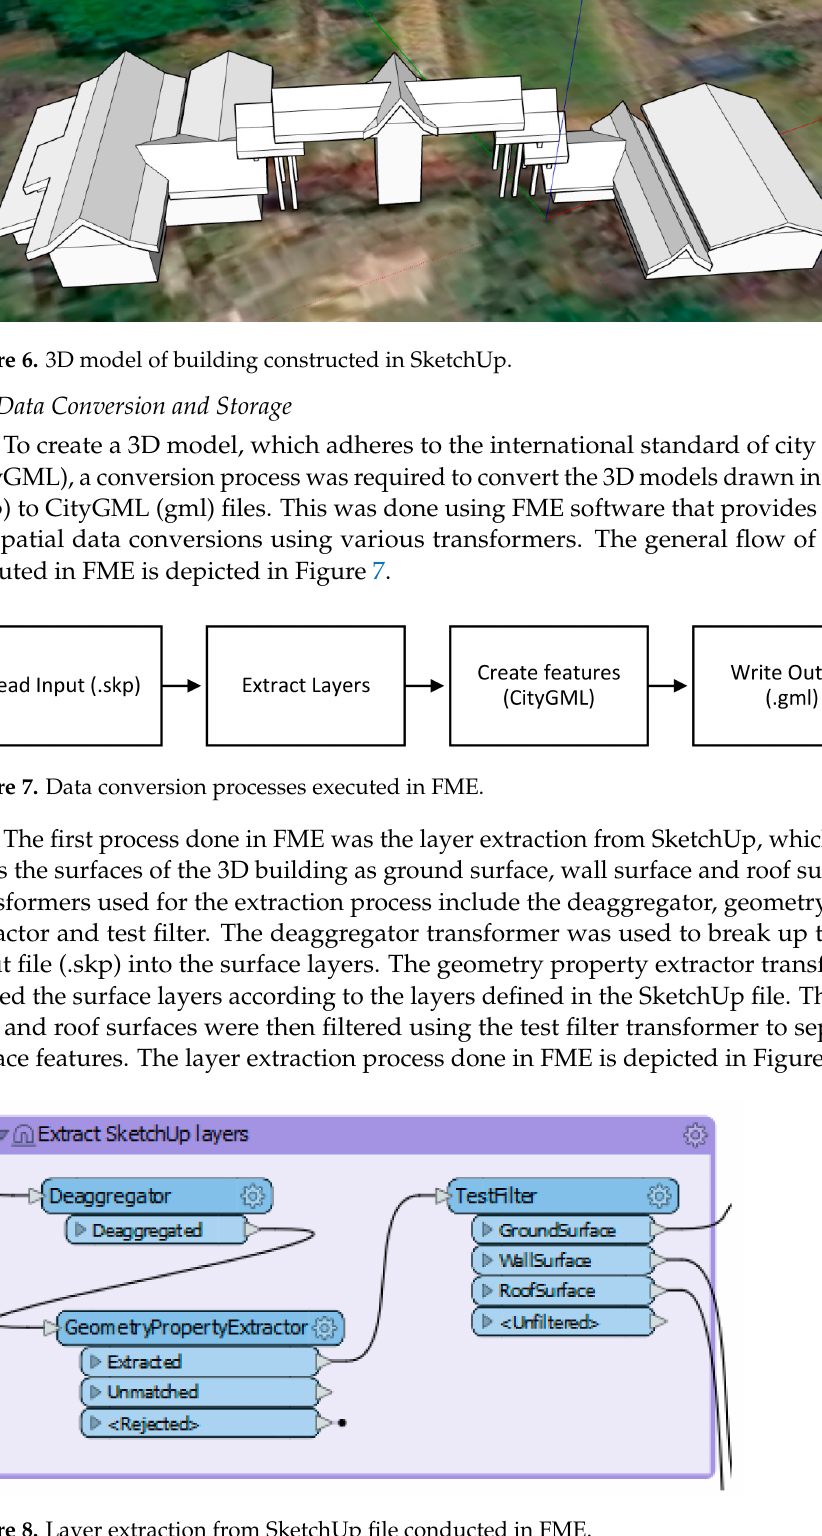
Figure 5. 3D model drawn in SketchUp according to ( a ) “GroundSurface” layer, ( b ) “WallSurface” layer and ( c ) “RoofSurface” layer.